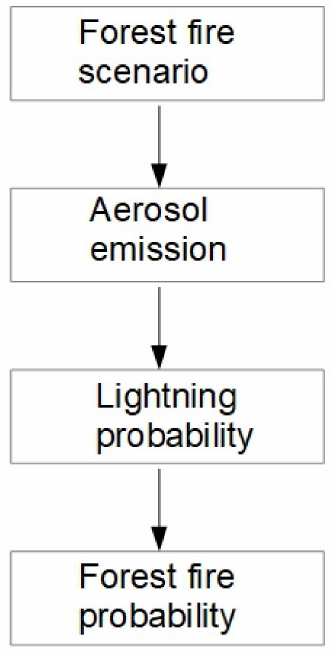
Figure 3. Linear